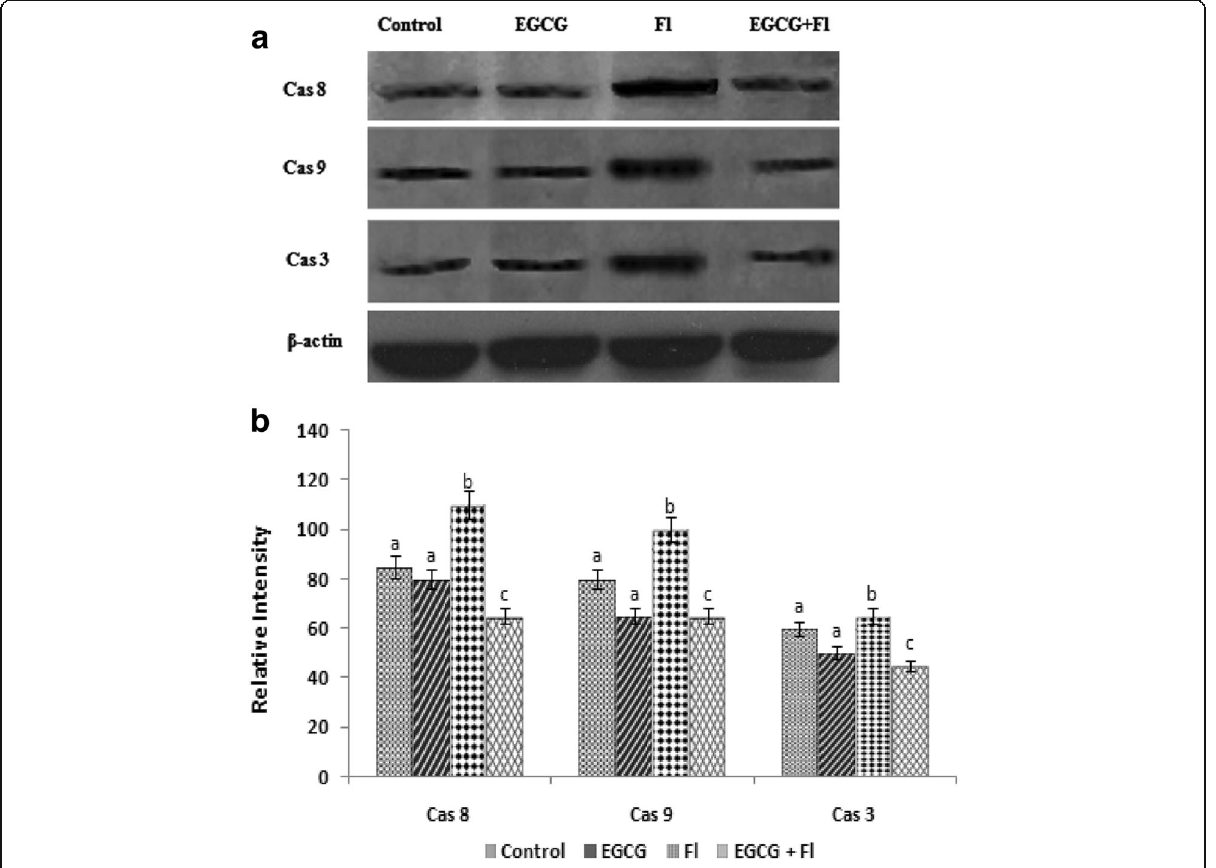
Fig. 11 Effect of EGCG on Caspases 8, 9, and 3 protein expression in the hippocampus of control and experimental rats. Values are mean ± SD for 6 rats in each group. a, b, c Values are not sharing a common superscript letter (a, b, and c) differ significantly at p < 0.05